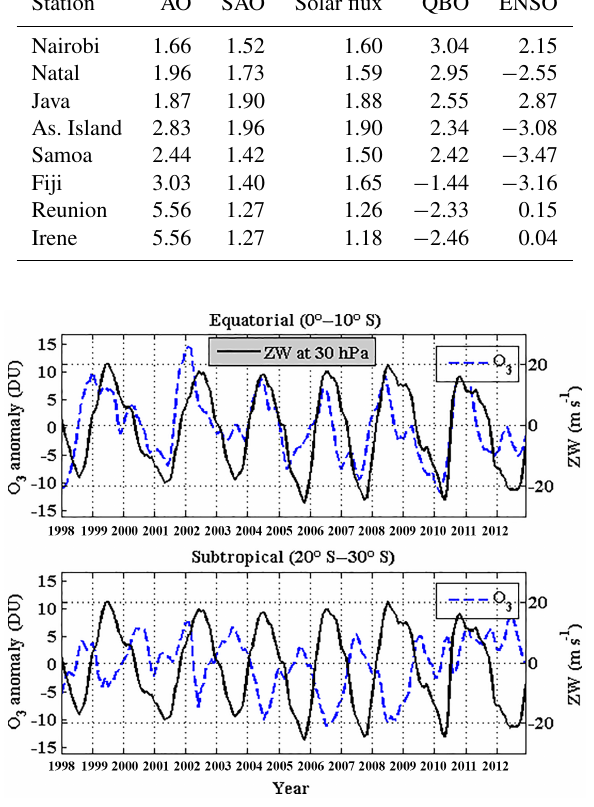
Figure 8. Deseasonalized time series of total ozone (blue line) for equatorial (0–10 ◦ S) and subtropical (20–30 ◦ S) regions calculated by subtracting the ozone monthly mean from the corresponding monthly climatological value. The black line is the time series in months of zonal wind recorded at 30hPa over